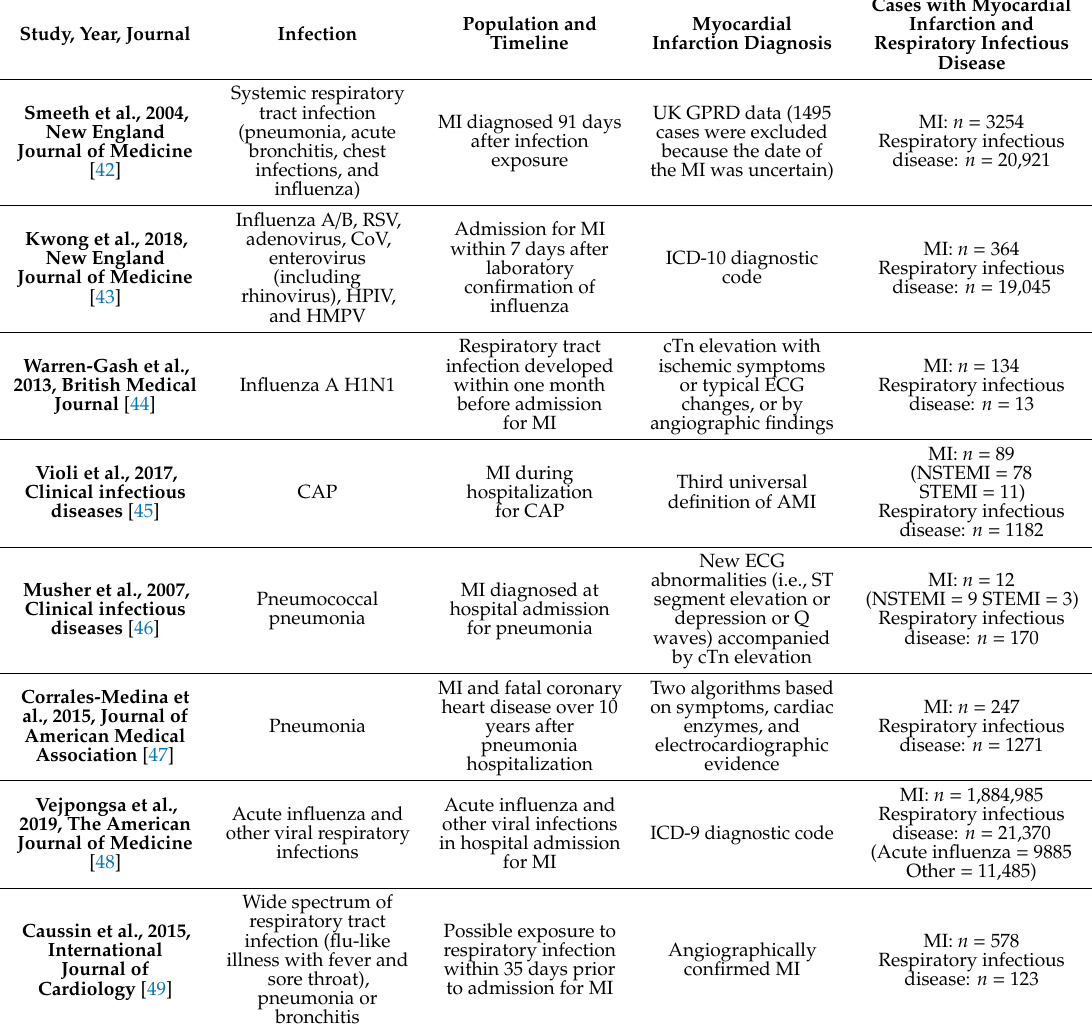
Table 2. Acute coronary syndromes and other acute respiratory infection—main